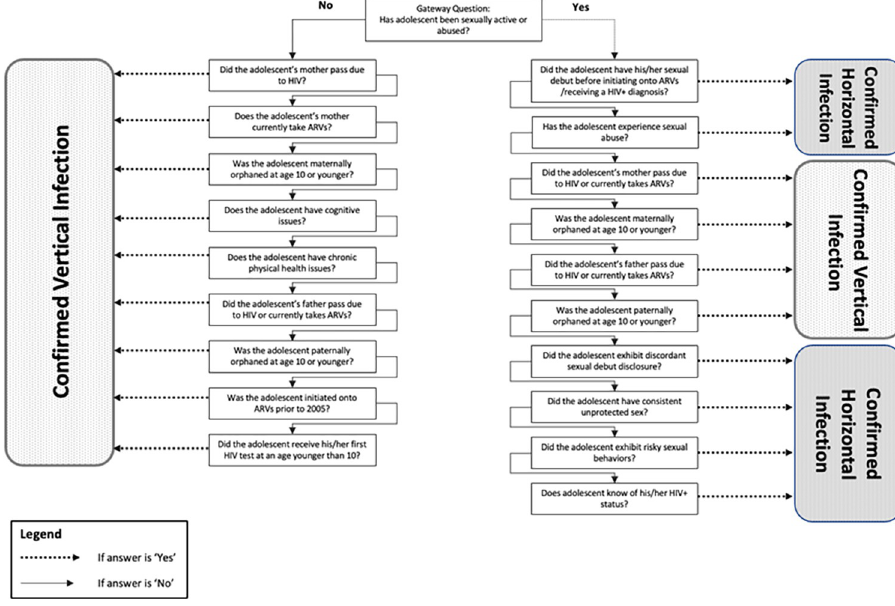
Fig 1. Logic tree diagram. Logic tree with each of the vertical acquisition side branches and sexual acquisition side branches to final MOHA determination.